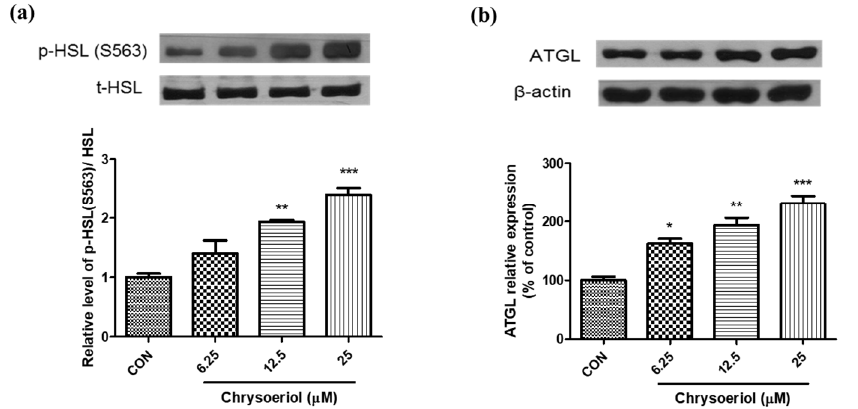
Figure 7. Effects of chrysoeriol on HSL phosphorylation ( a ) and ATGL expression ( b ) in 3T3-L1 adipocytes. *, **, *** p < 0.05, 0.01, and 0.001, respectively, significant difference compared with control group. CON, control (differentiated cells).